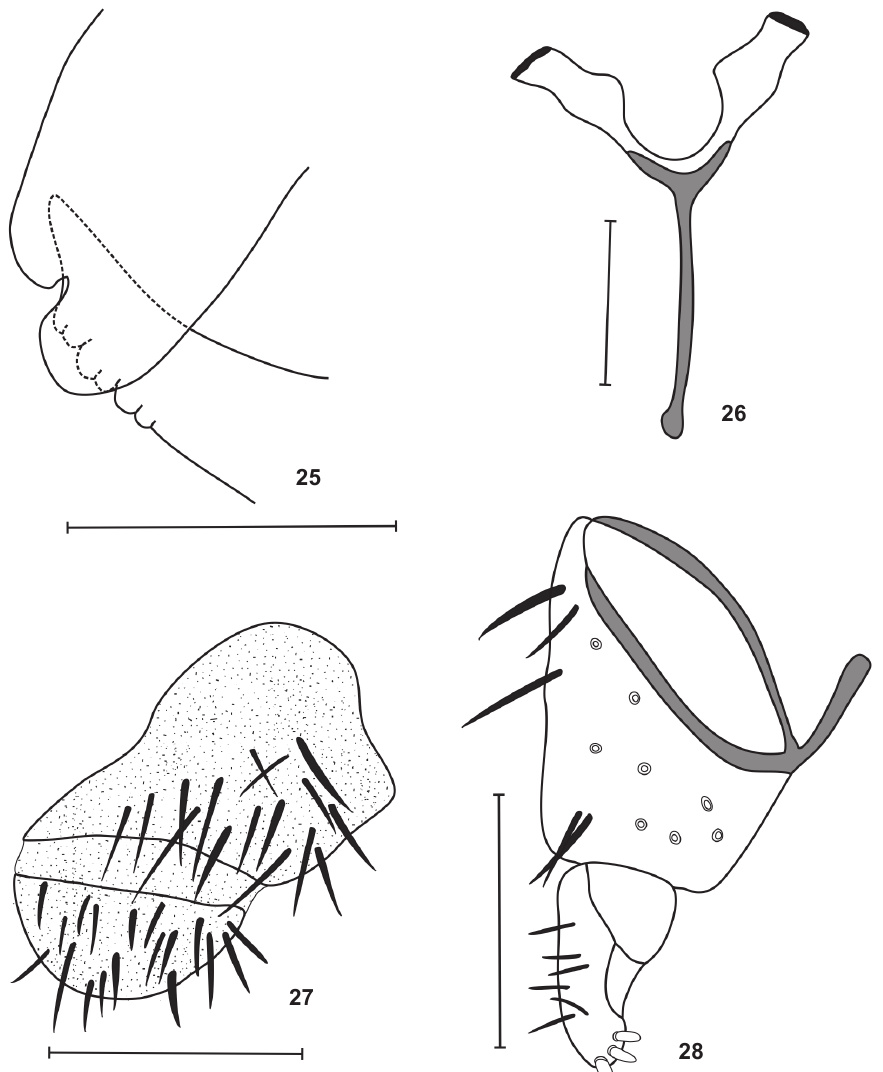
Figure 25-28. Adult of L. hirticosta : (25-27 female) (25) calcipala and pedisulcus; (26) genital fork; (27) cerci and paraproct. (28) male, gonocoxite and gonostylus. Bar: 0.1